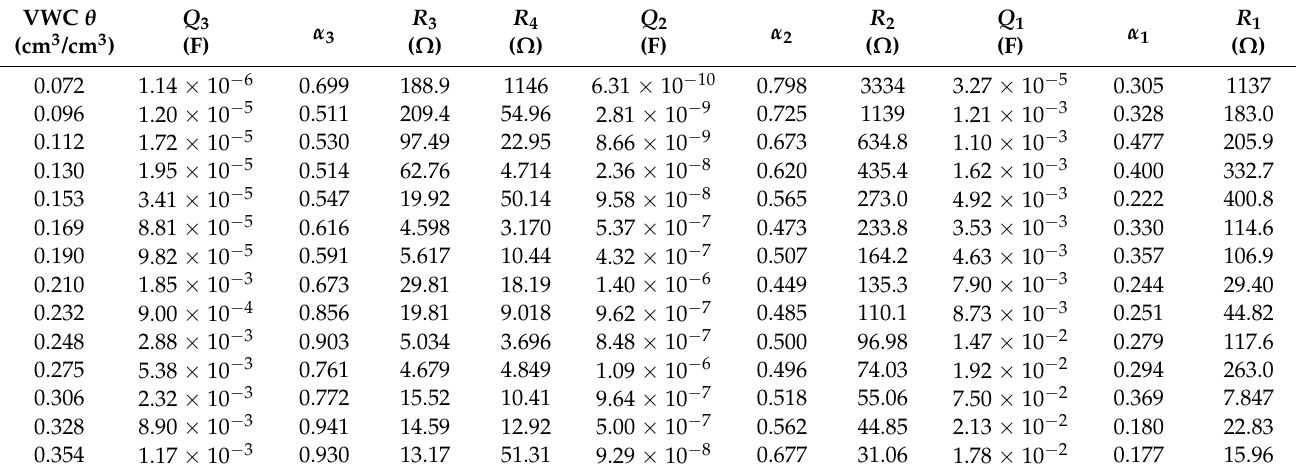
Table 2. Variation in equivalent circuit parameters of substrate affected by volumetric water content